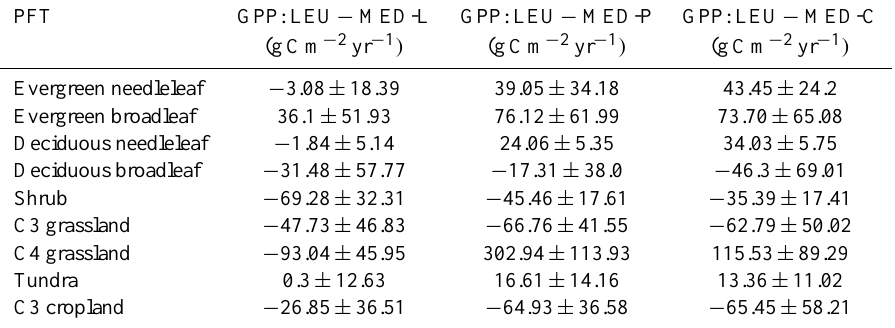
Figure 4. Mean diurnal modelled gross primary productivity (GPP), latent heat flux (LE), transpiration ( E ) and the observed (OBS) LE flux at the Howard Springs FLUXNET sites during daylight hours (8a.m.–7p.m.). Time series have been averaged across all years as described in Table 2 to produce diurnal seasonal cycles. Light blue shading indicates the uncertainty in predicted fluxes from the Medlyn model (MED-P), accounting for ± 2 standard errors in the site g 1 parameter value. Table 6. Mean and 1 standard deviation difference in annual GPP between the LEU and MED-L model, the LEU and MED-P models and the LEU-C models for each of CABLE’s PFTs. Where standard deviations are large relative to the mean it suggests large variability between the LEU and other models within a